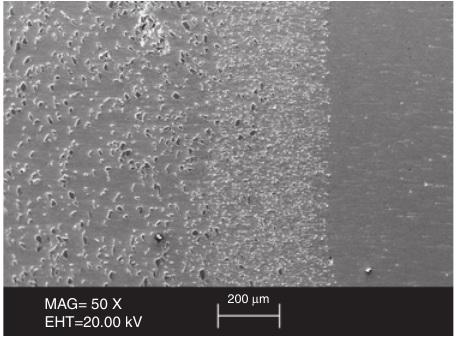
Figure 5 Schematic illustration of the shear strength testing apparatus.